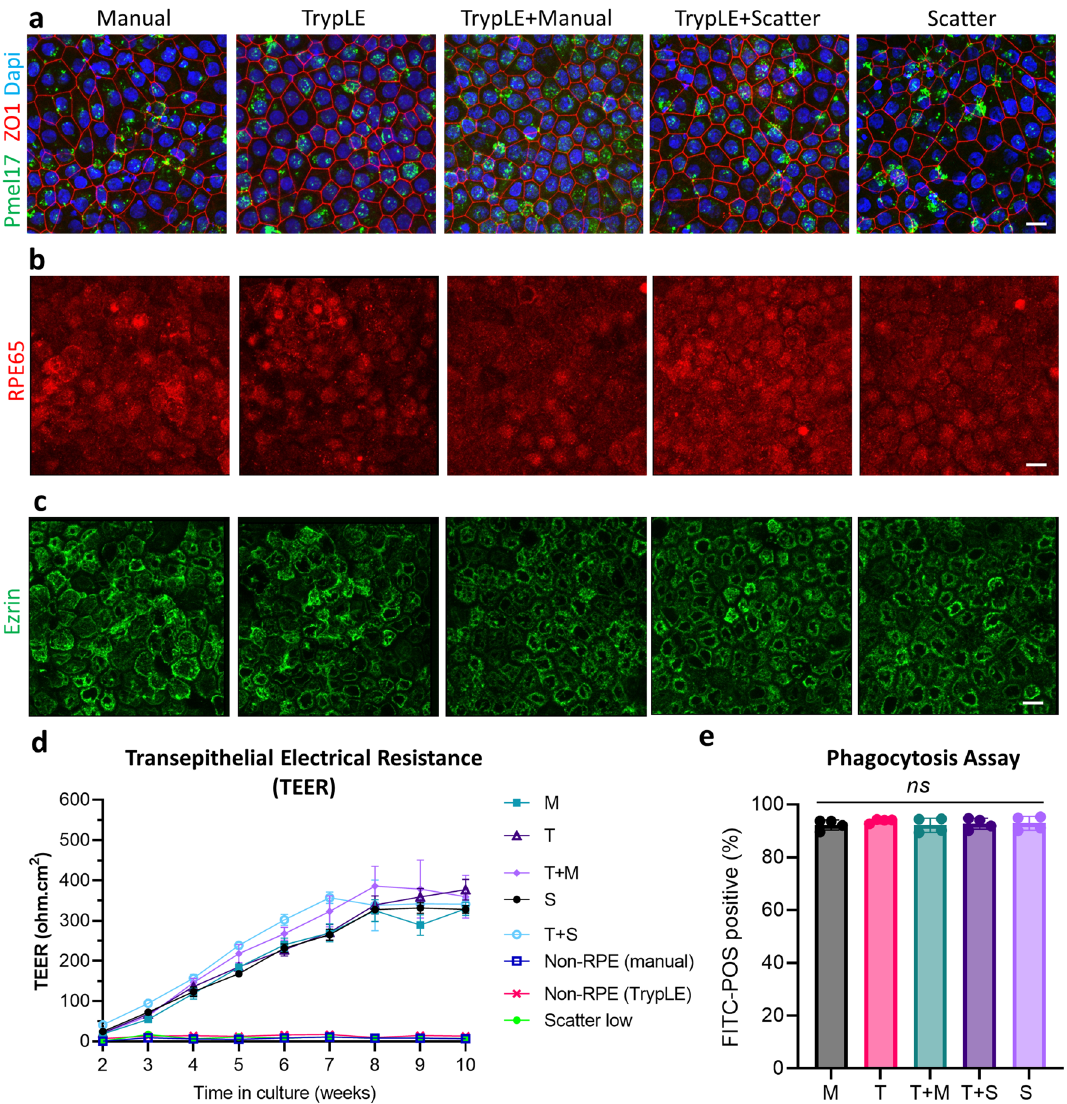
Figure 4. Functional characterization of purified HDFa RPE cells obtained from all methods. ( a – c ) Immunostaining for RPE-specific functional proteins, ( a ) zonula occludens-1 (ZO-1) and PMEL17, ( b ) RPE65, and ( c ) Ezrin. Scale bar for (a – c), 10 μm ( d ) Barrier formation of purified RPE cells and non-RPE was monitored using TEER for 10 weeks and showed progressive increase only for purified RPE cells. ( e ) Functional phagocytosis studied using internalization of FITC-labelled POS and showing > 92.1% uptake for RPEs obtained from all five methods. Statistical analysis was calculated using one-way ANOVA, followed by Tukey’s honest significance difference (HSD) post hoc test. ns , not